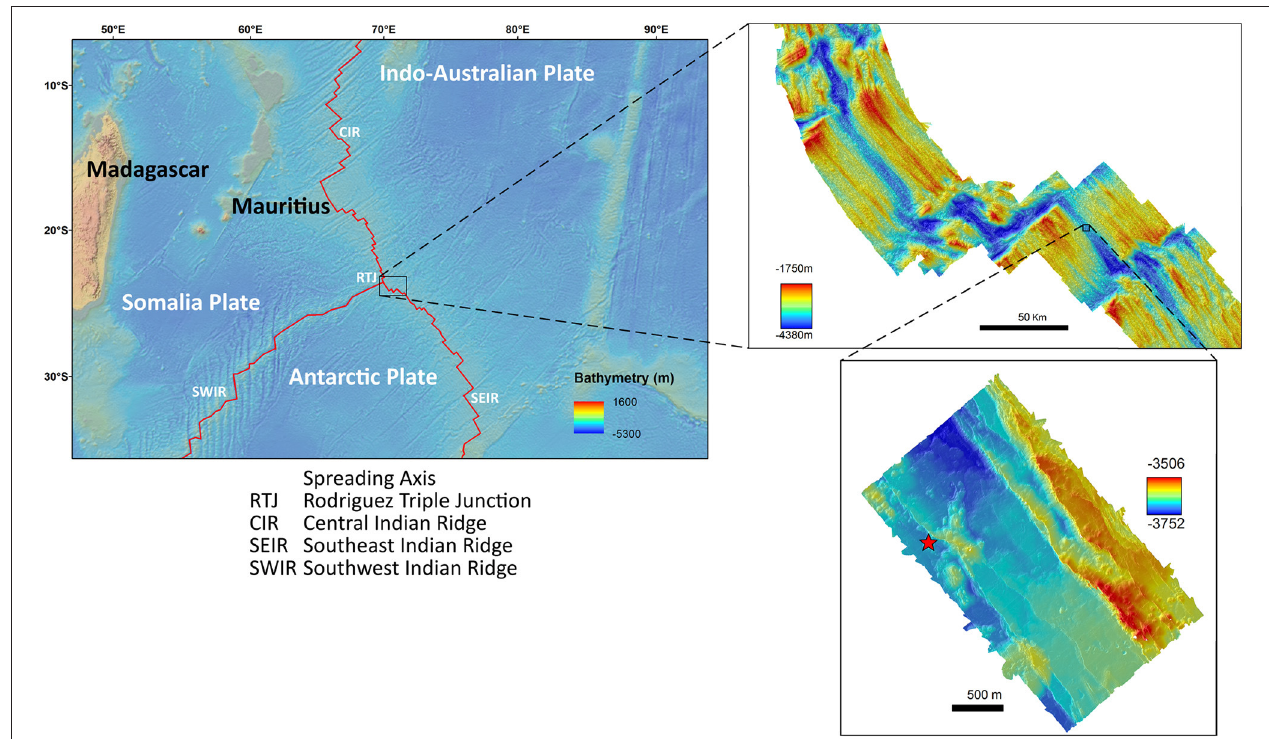
FIGURE 1 | Maps of the study area showing the location of data collection. The red star indicates the vent field in a depth of